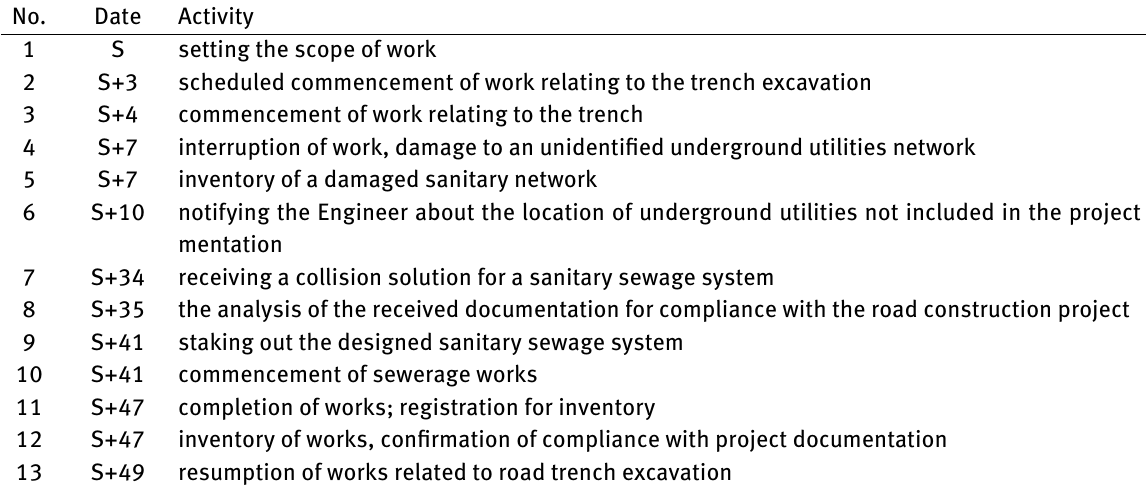
Table 4: Separate part of the schedule in which the R4 factor occurred, Source: own elaboration.